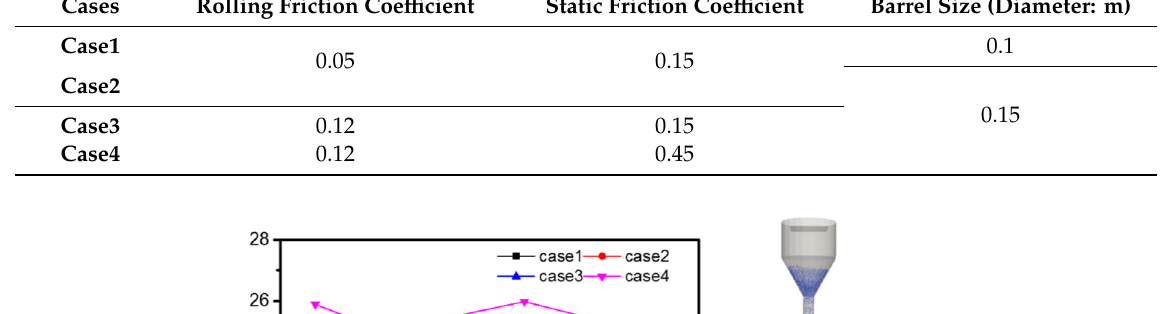
Figure 7. The angle of repose for different lifting velocities. Pink dotted and solid lines represent the angle of repose with different packing methods, but the same DEM parameters. Table 3. Different cases studied by the Lifting Method.